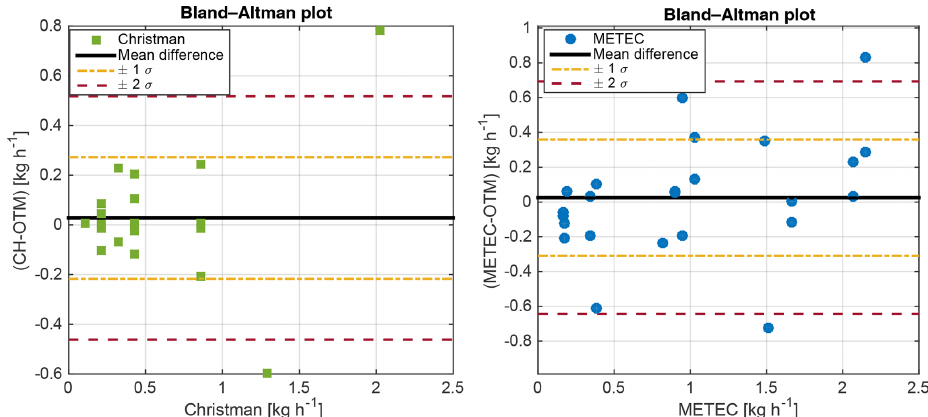
Figure 7. Bland–Altman analysis of Christman and METEC test releases. Bold black lines represent the mean difference between the test release and the OTM measurement, while the dashed yellow and red lines indicate 1 and 2 standard deviations of the method difference.